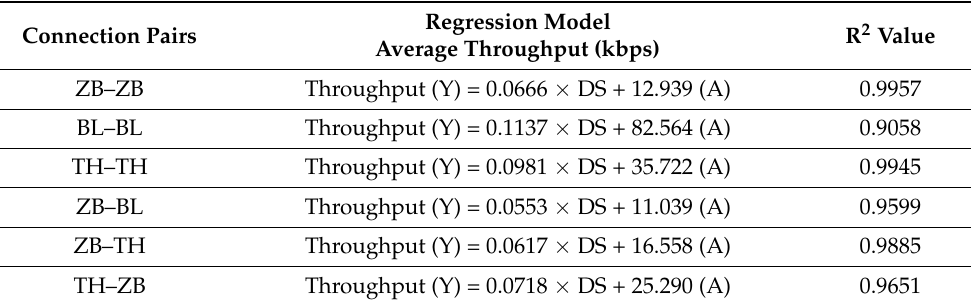
Table 6. Univariate Regression Models Built Based on the Average Throughput.